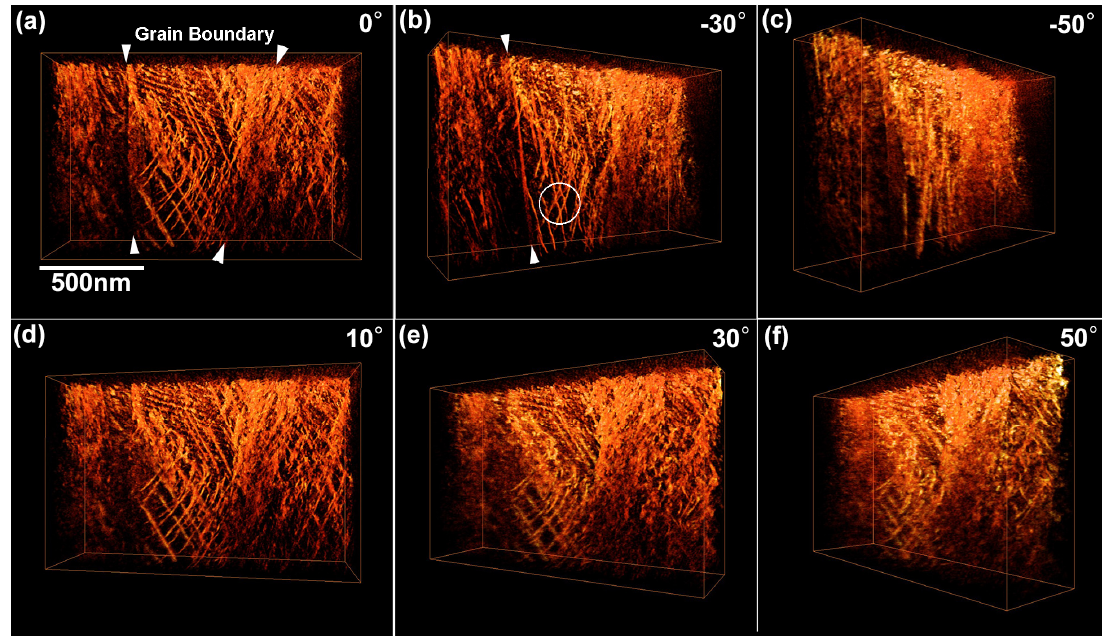
Figure 5. Three-dimensional views of the dislocations reconstructed from a BF-STEM tilt-series dataset using a weighted back-projection (WBP) technique. Arrowheads indicate — the α ''/ β grain boundary. A kink on a (1 01) slip plane is seen in the encircled